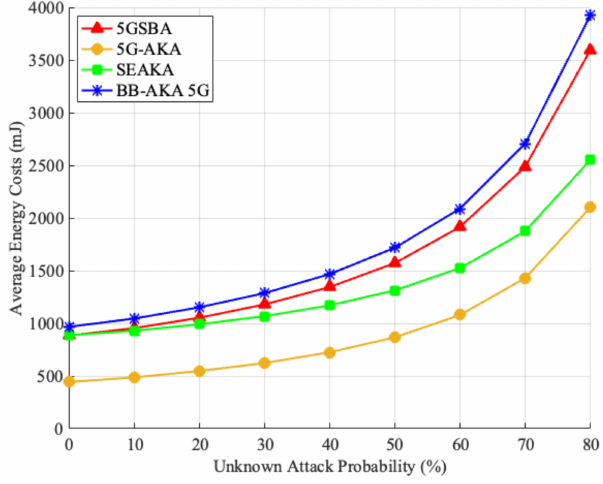
Figure 9. Energy consumption for